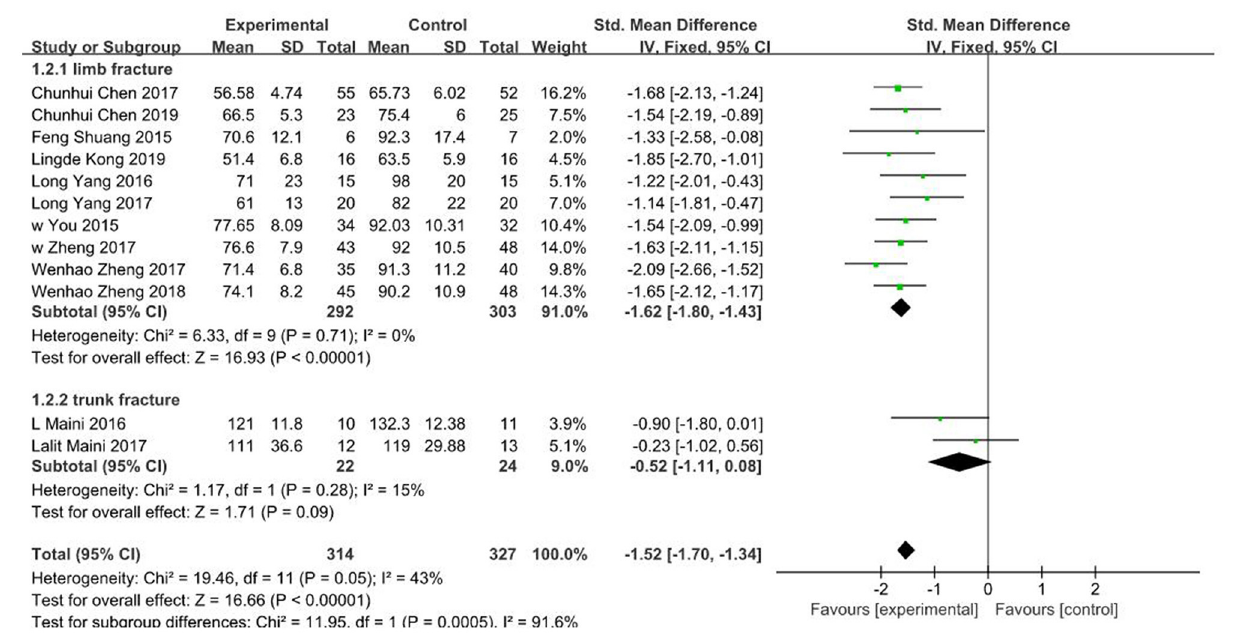
FIGURE 3 | Meta-analysis results of operation time.